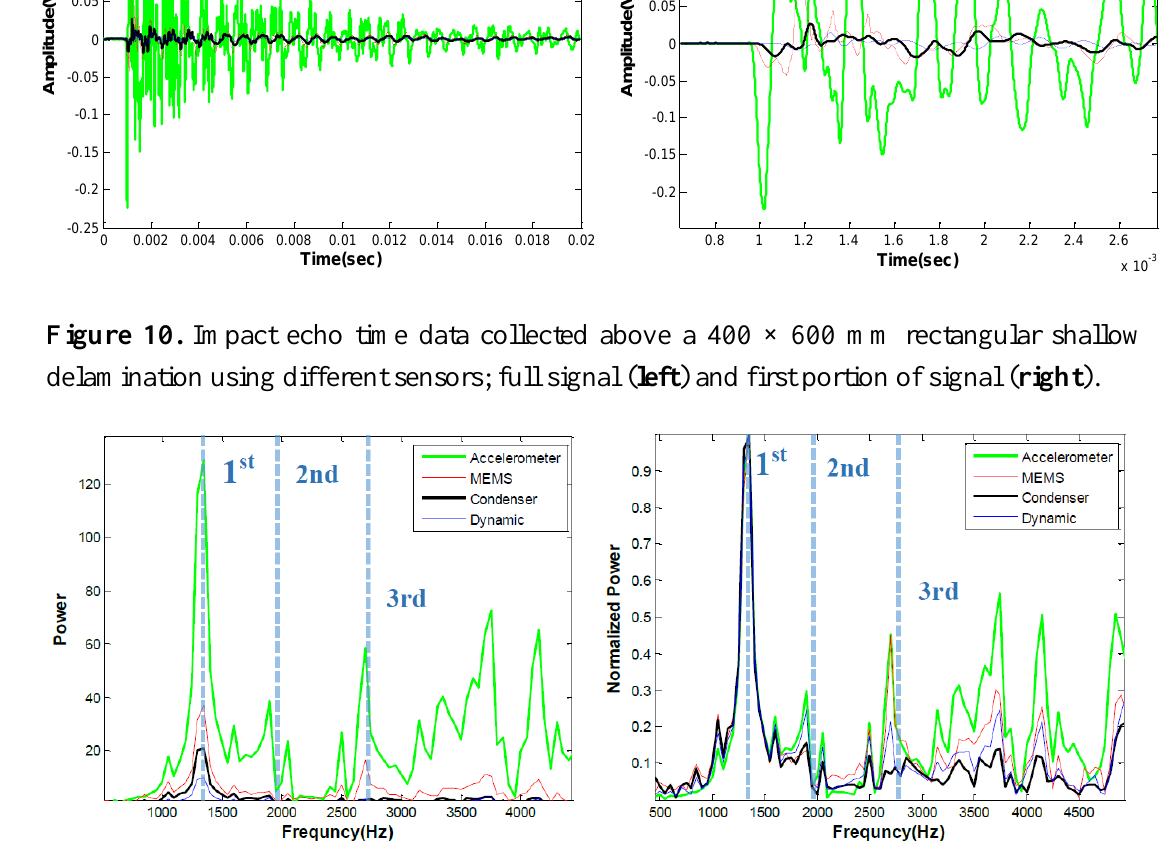
Figure 11. Impact echo frequency data collected above a 400 × 600 rectangular shallow delamination using different sensors; absolute data ( left ) and normalized data (right ). Frequency of first three expected vibrational modes indicated with dashed lines.